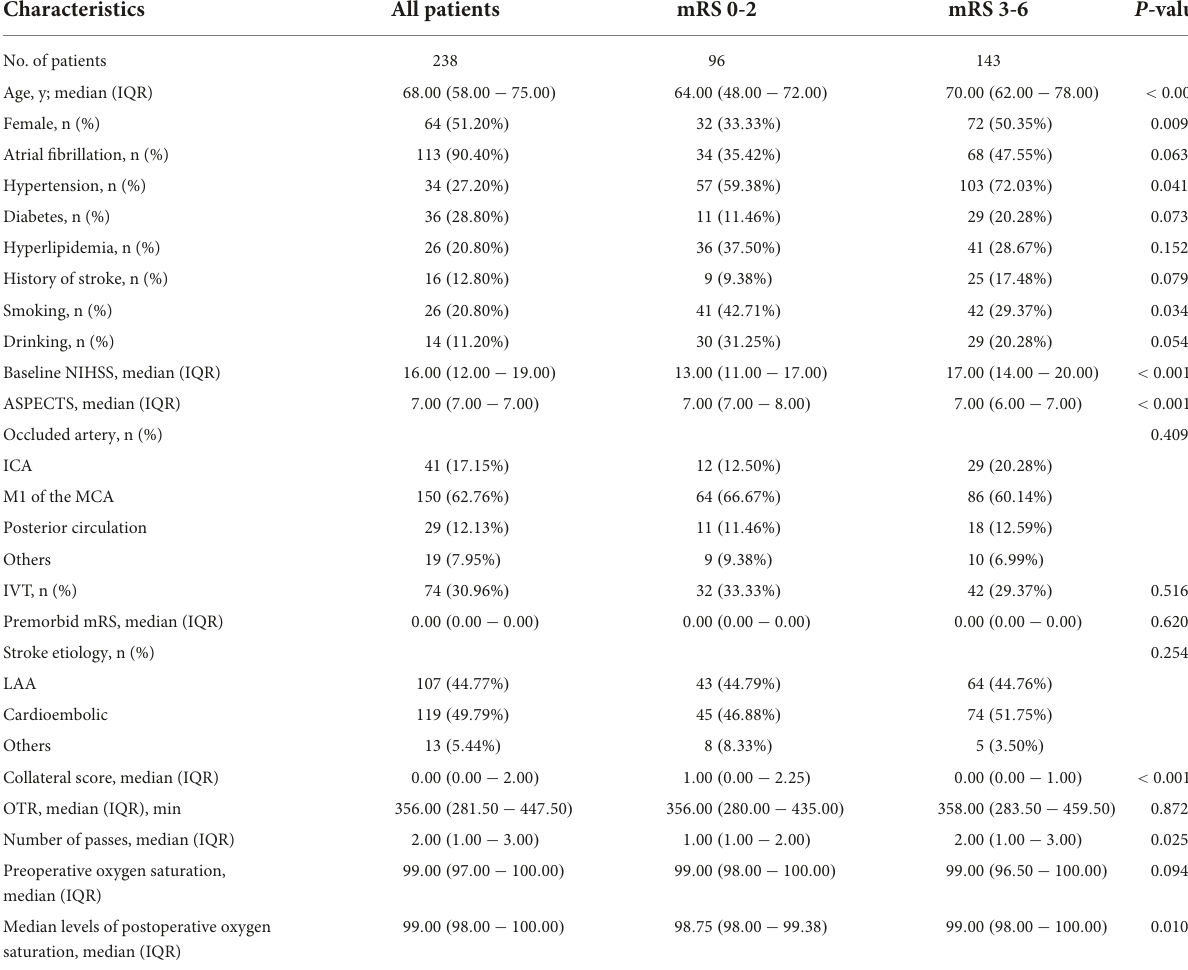
TABLE 1 Baseline characteristics of study participants according to the development of poor outcome.